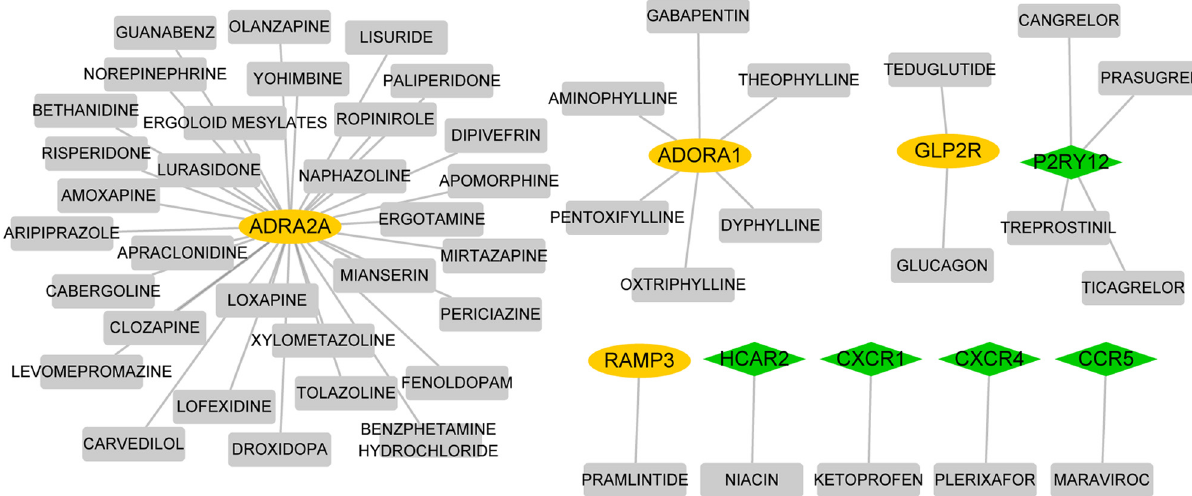
Figure 6: Network construction of drug – gene interaction. Yellow circle nodes are upregulated genes; gray square nodes are drug molecules. The yellow circle represents the upregulated gene, the green prismatic represents downregulated